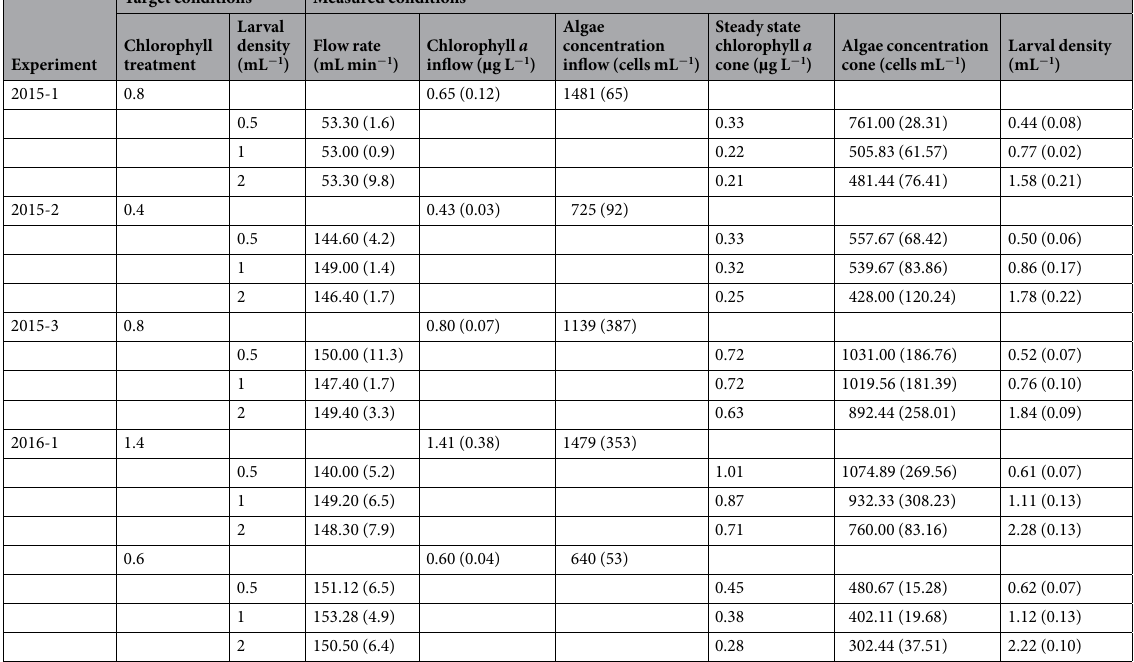
Table 1. Details for treatment and measured conditions for four experiments on Acanthaster cf . solaris development undertaken in 2015 and 2016. Treatments were high and low chlorophyll and three larval densities (0.5, 1 and 2 larvae mL − 1 ). In 2015 the two chlorophyll conditions were tested separately in the experiments, high chlorophyll was tested in experiment 1 and 3 and low chlorophyll in experiment 2. Larvae density (larvae mL − 1 ± SD) measurements were taken 5 times during all experiments (n = 5, exception of experiment 3 high chlorophyll n = 3. The flow rate (mL min − 1 ± SD) was set manually during the experiment (experiment 1 and 2 n = 2, and experiment 3 n = 3). The chlorophyll concentration entering the cones was measured as chlorophyll a inflow ( µ g L − 1 ± SD) (experiment 1 and 3 n = 2, and experiment 2 n = 3) and checked